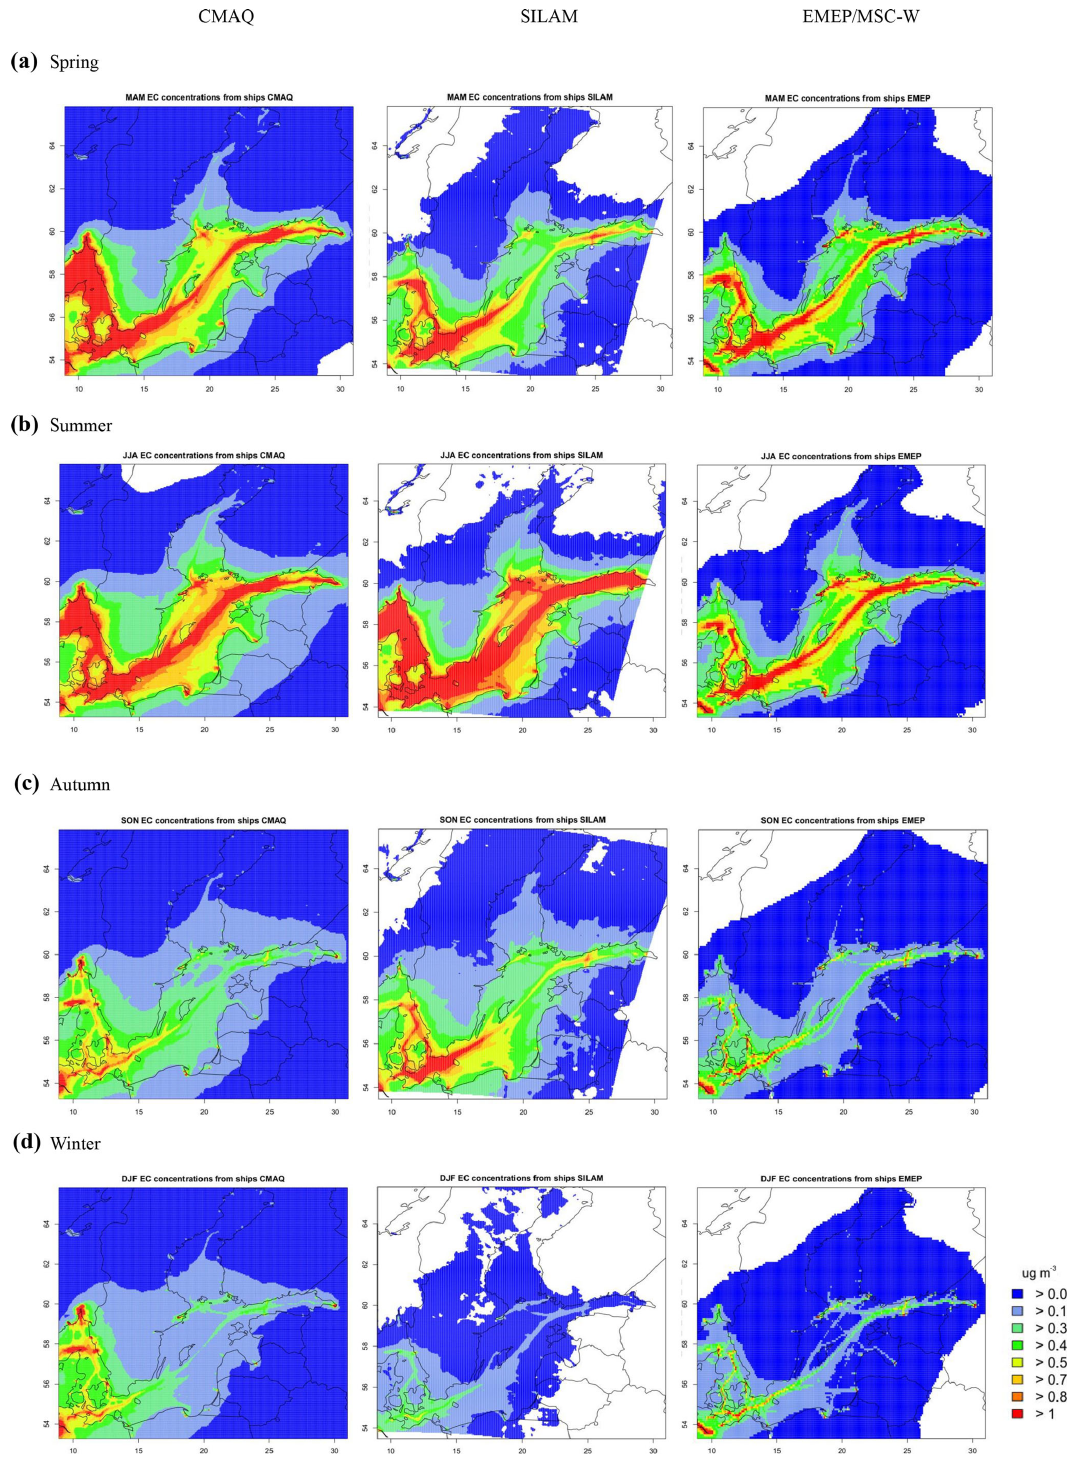
Figure 11. Spatial distribution of the seasonal mean EC ship contribution (µgm − 3 ) from CMAQ (left column), SILAM (middle column) and EMEP (right column) in the Baltic Sea region for (a) spring, (b) summer, (c) autumn, and (d) winter. Empty areas correspond to concentrations between zero and the lowest value in the